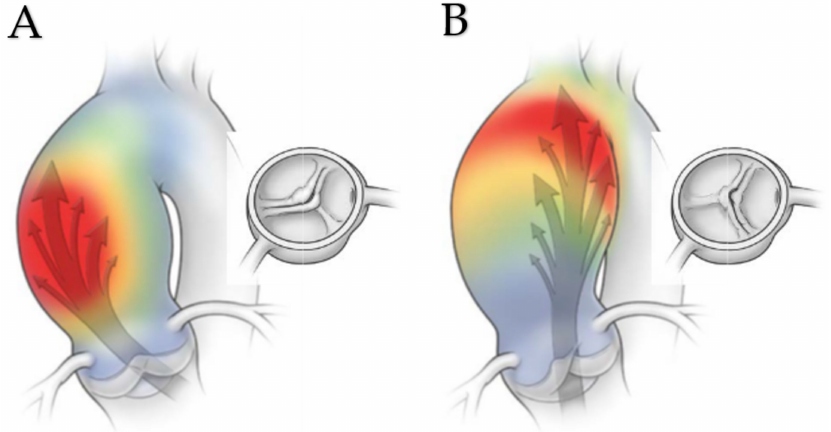
Figure 5. ( A , B ). Representation of morphologic chacteristic of the bicuspid aortic valve influencing the pattern of aortopathy. The fusion pattern of the aortic valve cusps is responsible for changes due to shear stress on the aortic wall and in the resulting flow pattern. ( A ) In the right–left fu- sion model, the jet is directed towards the right anterior wall of the ascending aorta, where it moves in a right-hand helical direction to promote dilation predominantly of the ascending aorta. ( B ) In contrast, in the model characterized by a fusion of the right and non-coronary cusps , the jet is directed towards the posterior wall of the aorta, so the model of shear stress of the wall it causes can favor aortic expansion at the internal proximal arch. Licenses Centre Cardiologique du Nord; order date 27 July 2022; order number 5357160571198; publication NEJM; Title: Aortic Dilatation in Patients with Bicuspid Aortic